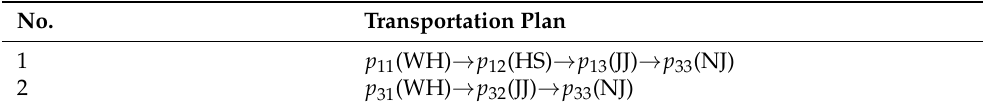
Table 1. Feasible transportation plans from Wuhan to Nanjing.